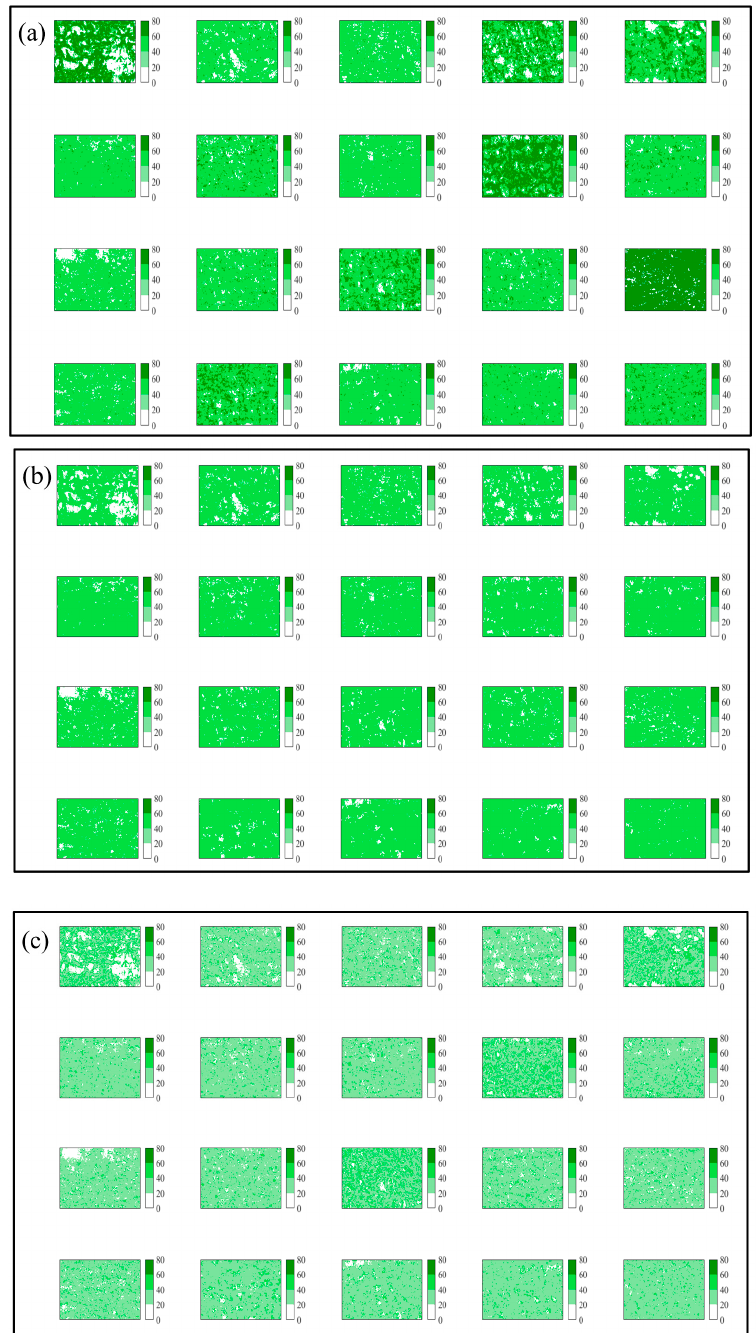
Figure 4. The predicted chlorophyll contents values by BP, SVM, and RF models using images acquired on 16 September 2019. Note: ( a – c ) represented the predicted chlorophyll contents using BP, SVM and RF,